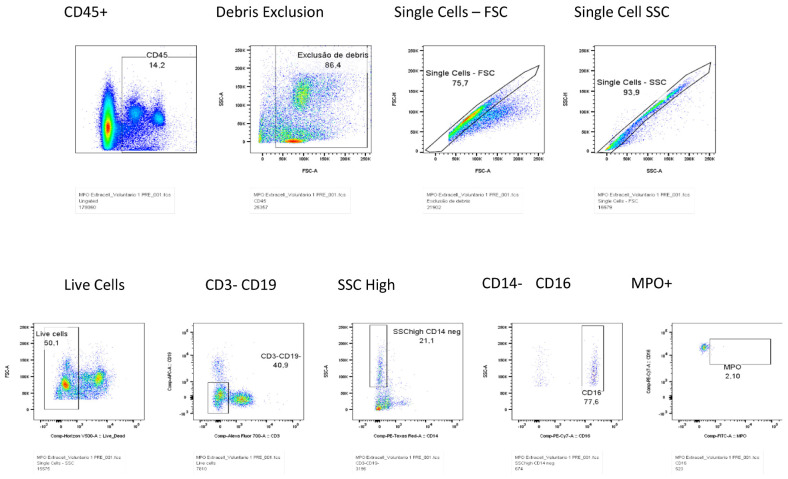
Flow cytometry gates definition Immunophenotyping.